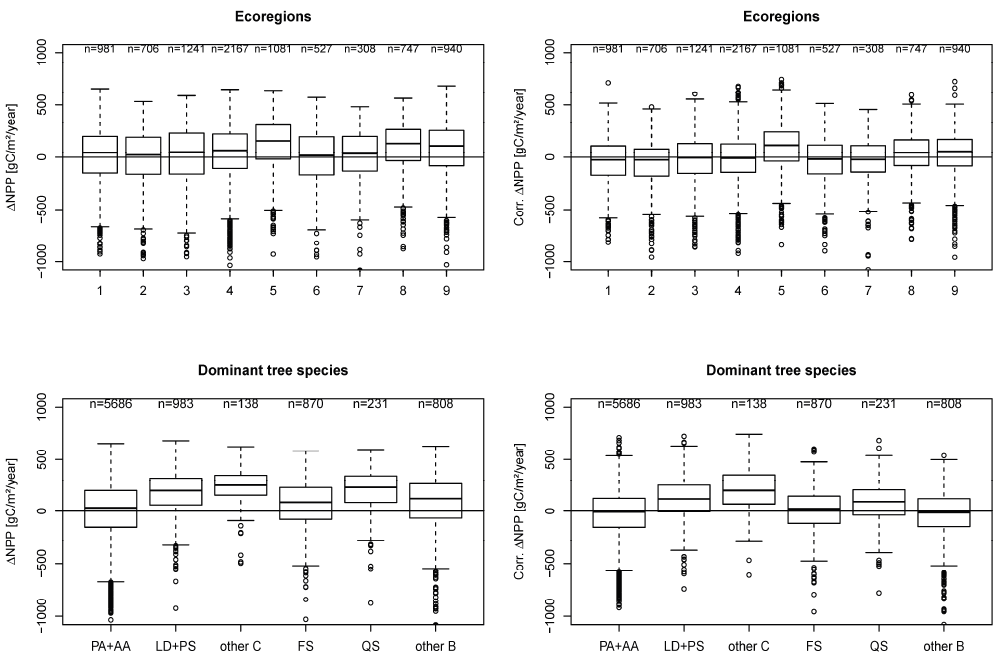
Figure 6. Difference between MODIS NPP and NFI NPP (MODIS minus NFI) grouped by ecoregions ( top ) and dominant tree species ( bottom ). Left original MODIS NPP ( ∆ NPP) is used, right the detrended MODIS NPP (Corr. ∆ NPP) is used. Properties of illustration analogous to Figure 2.